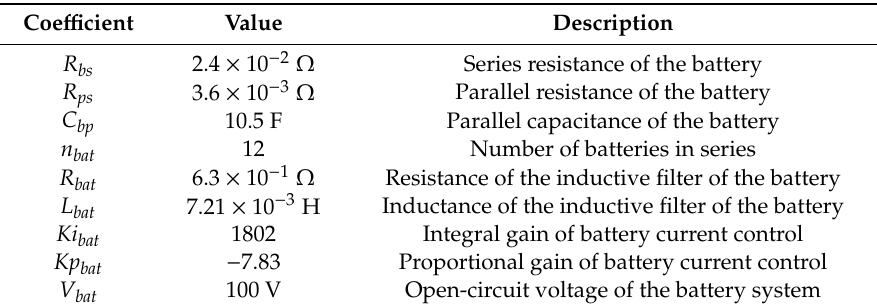
Table 1. Parameters of the battery storage system.